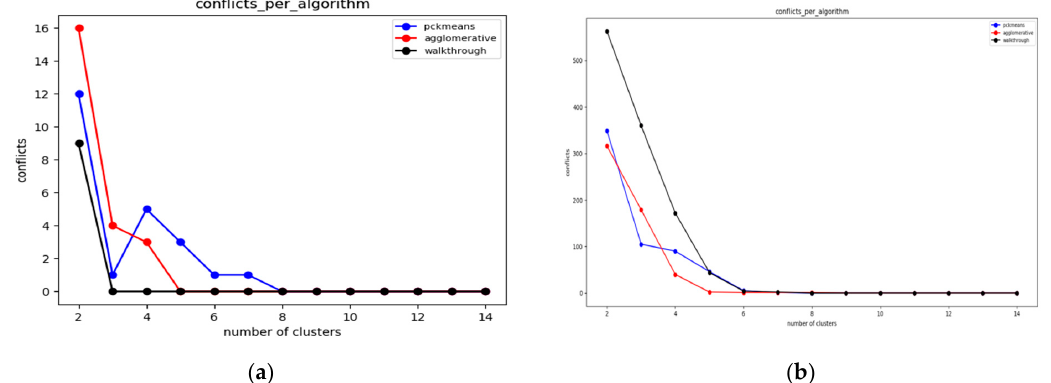
Figure 8. Evaluation results for static clustering over the topology of 100 nodes for ( a ) r s = 3, a = 0 and ann = 1.4, ( b ) r s = 4.5, a = 2.6 and ann = 22.6.